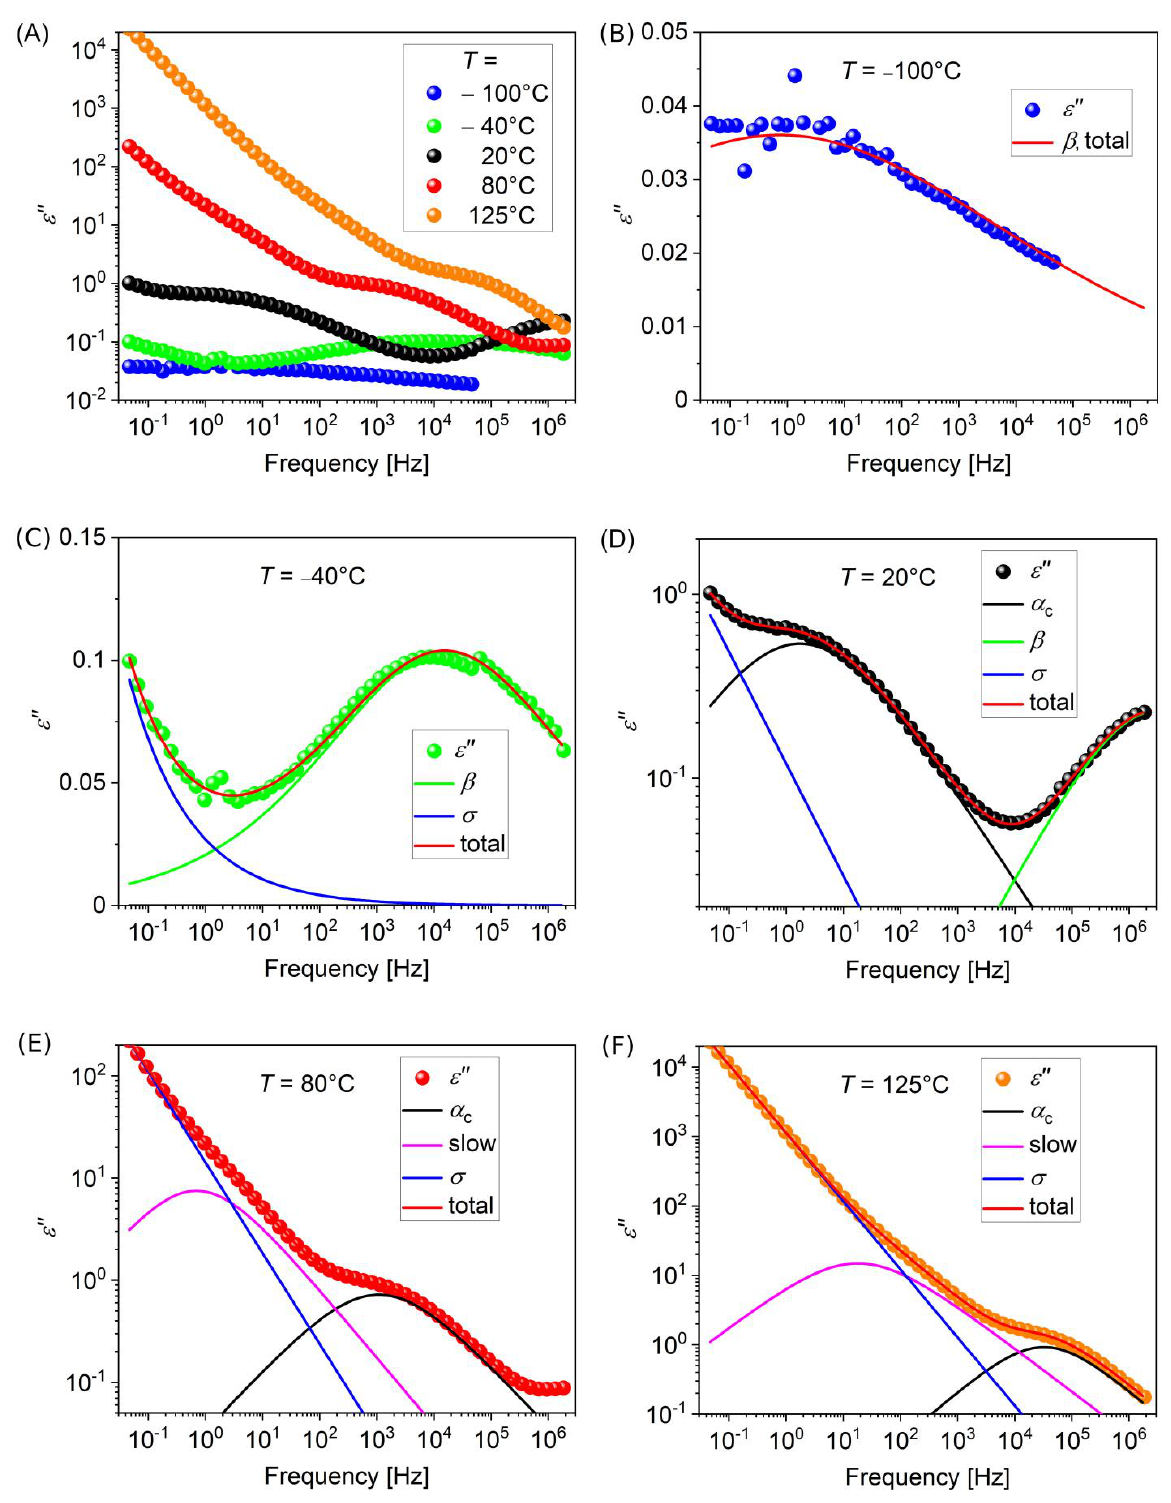
Figure 3. ( A ) Frequency dependence of the dielectric loss (imaginary part of permittivity) of RAFT PVDF at selected temperatures. ( B – F ): single spectra at each temperature, along with fitting curves related to the three relaxation processes as well as to the conductivity contribution. Blue curve: conductivity, green curve: β relaxation, black curve: α c relaxation, magenta curve: slow relaxation, red curve: overall